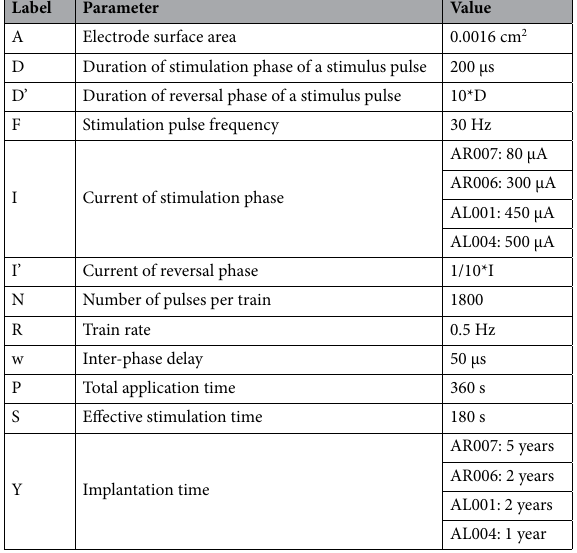
Table 2. Standard stimulation parameters. Parameters that were individual for each participant are marked with patient IDs.